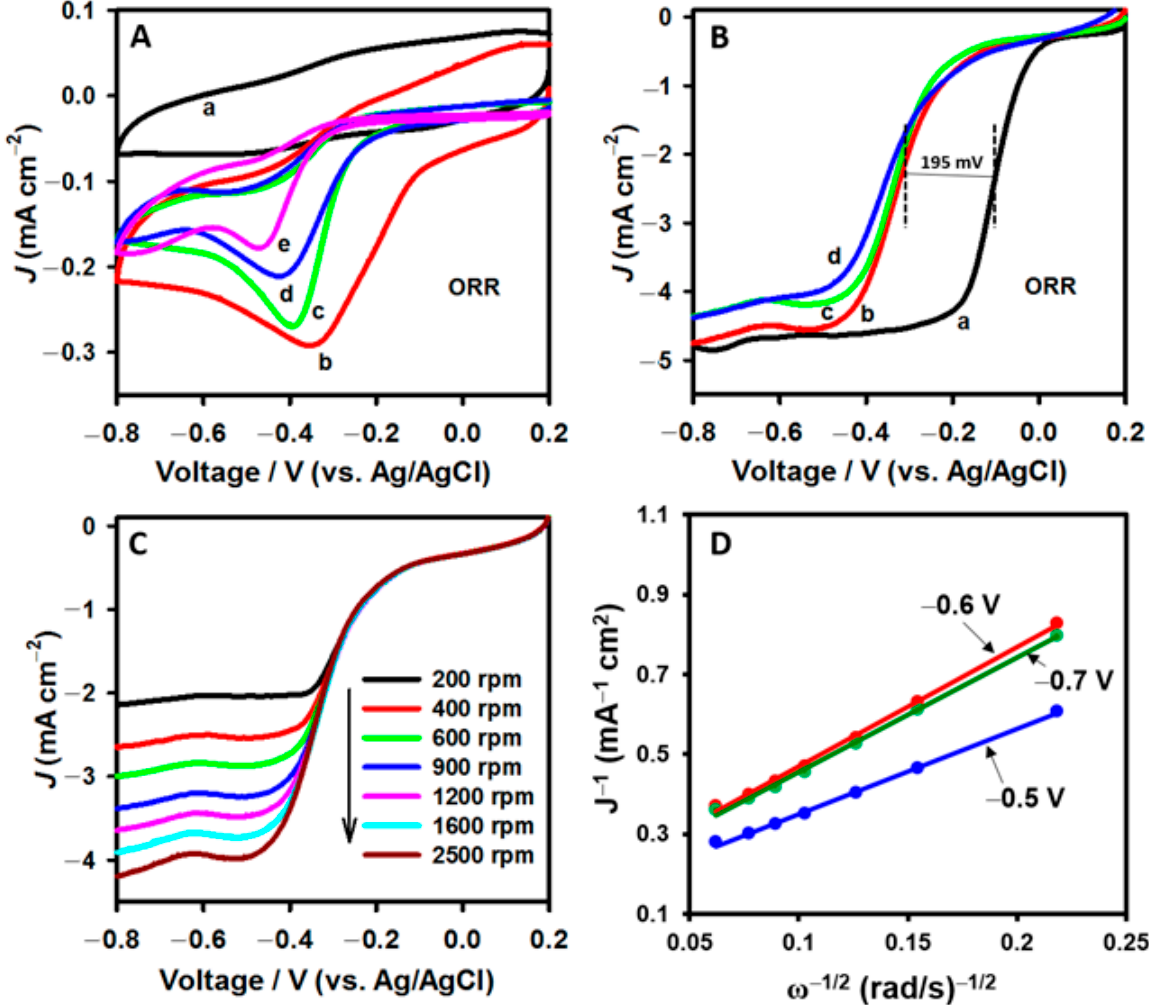
Figure 5. ( A ) CV curves of ORR activity at LaMnO 3 @C-Co 3 O 4 catalyst electrode ( a ) in N 2 -saturated and LaMnO 3 @C-Co 3 O 4 ( b ), LaMnO 3 @C-RuO 2 ( c ), LaMnO 3 @C ( d ) and LaMnO 3 ( e ) in O 2 -saturated 0.1 M KOH electrolyte at a scan rate of 50 mV Scheme 1. ( B ) LSV polarization curves for ORR activity at Pt/C ( a ), LaMnO 3 @C-Co 3 O 4 ( b ), LaMnO 3 @C-RuO 2 ( c ), LaMnO 3 @C ( d ) in O 2 -saturated 0.1 M KOH electrolyte at a scan rate of 20 mV s − 1 with rotation speed of 1600 rpm. ( C ) RDE measurements of LaMnO 3 @C-Co 3 O 4 catalyst electrode at different rotation speeds of 200–2500 rpm. ( D ) Koutecky-Levich relation between j − 1 and ω − 1/2 at LaMnO 3 @C-Co 3 O 4 electrode at different potentials.